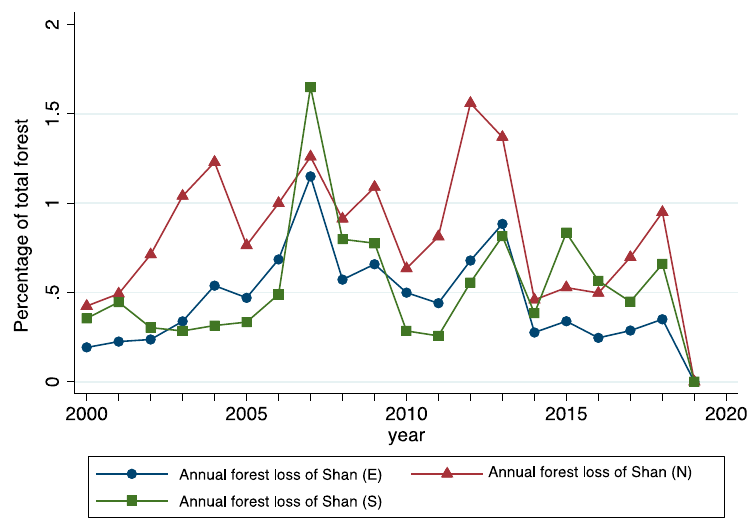
Figure 3. Percentage of yearly forest loss in different parts of Shan State .